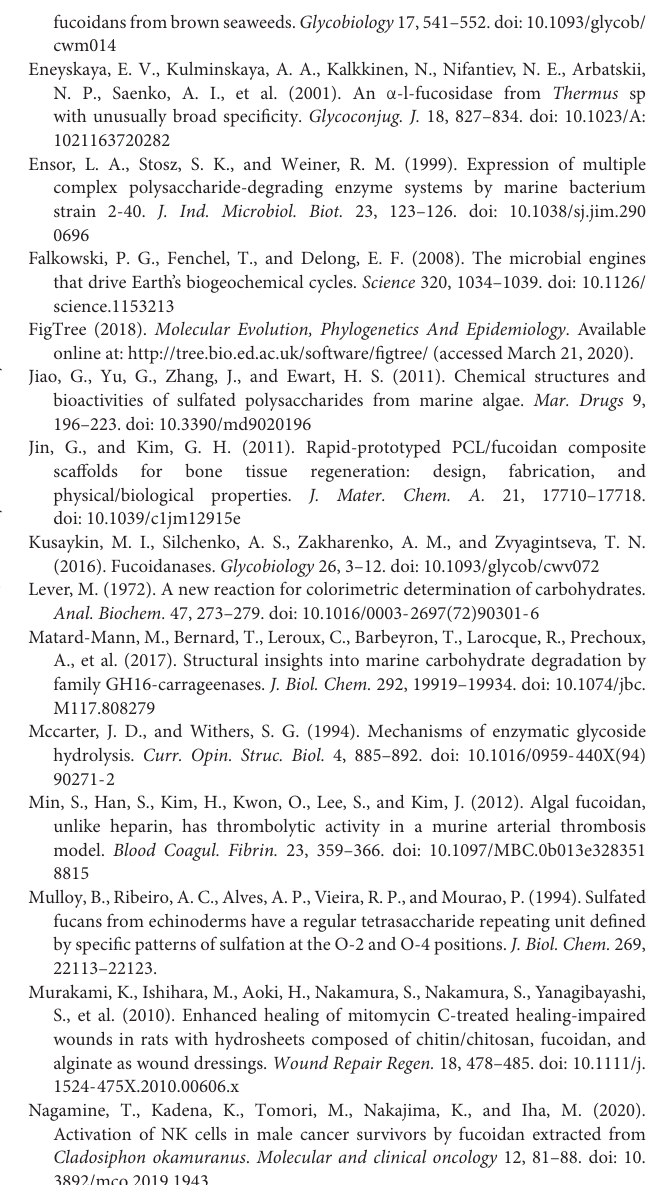
FIGURE S9 | SDS-PAGE analysis of recombinant potential homologues of FunA. M: M w standard markers; Line 1: control group; Line 2: cell lysate supernatant of WP_103190783.1; Line 3: cell lysate supernatant of WP_103191473.1; Line 4: cell lysate supernatant of WP_007280708.1; Line 5: cell lysate supernatant of XP_001749192.1; Line 6: control group; Line 7: cell lysate supernatant of WP_083194459.1; Line 8: cell lysate supernatant of WP_009100260.1; Line 9: cell lysate supernatant of WP_068825890.1; Line 10: cell lysate supernatant of WP_083194635.1; Line 11: control group. The over-expressed proteins were indicated with red rectangles. FIGURE S10 | Multiple sequence alignment of residues in FunA and its homologues. The strictly conserved residues in all sequences were indicated with black triangles.